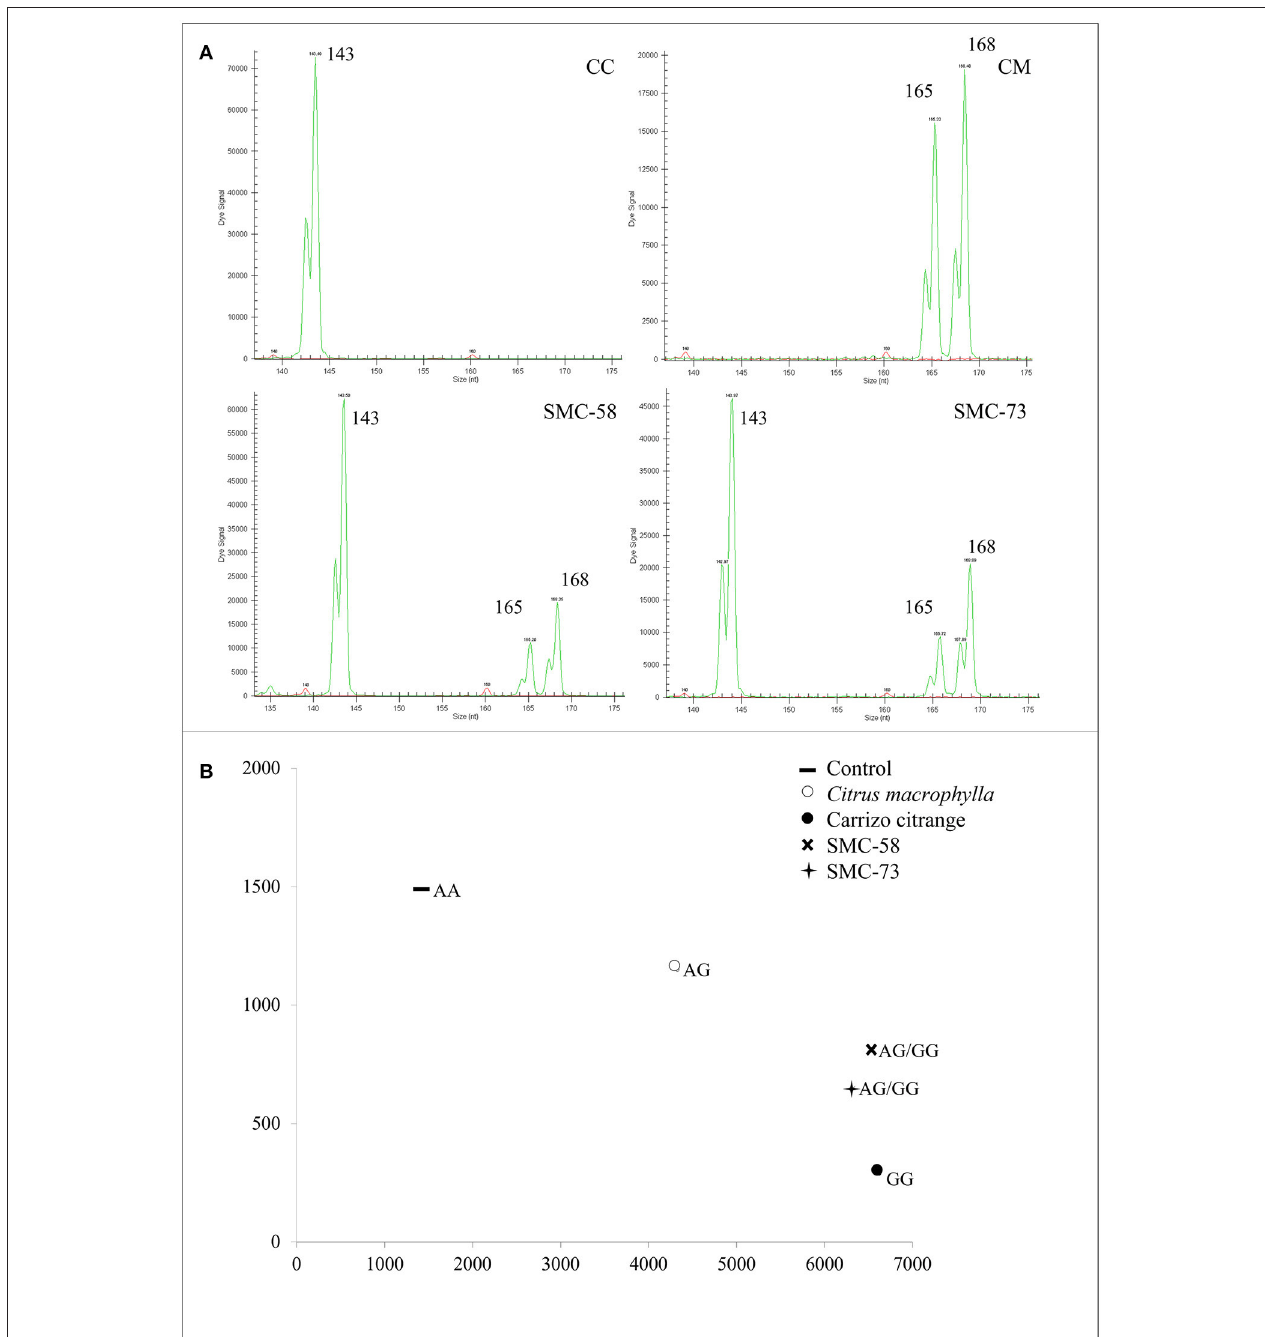
FIGURE 1 | Allelic configurations on LG 1 that correspond to the addition of both parents. (A) Electropherograms of the somatic hybrids SMC-58 and SMC-73 displaying four different alleles from their parents C. macrophylla (CM) and Carrizo citrange (CC) using JK-TAA15 SSR marker. Numbers indicate the size of the amplified allele in nucleotides (nt). (B) Plot of allele signals of ACO-C601 SNP marker in somatic hybrids and their parents. CM displayed AG alleles, Carrizo citrange displayed GG alleles and somatic hybrids display AGGG alleles. Letters indicate the allelic configuration for each genotype as: A, adenine; C, cytosine; T, thymine; G,